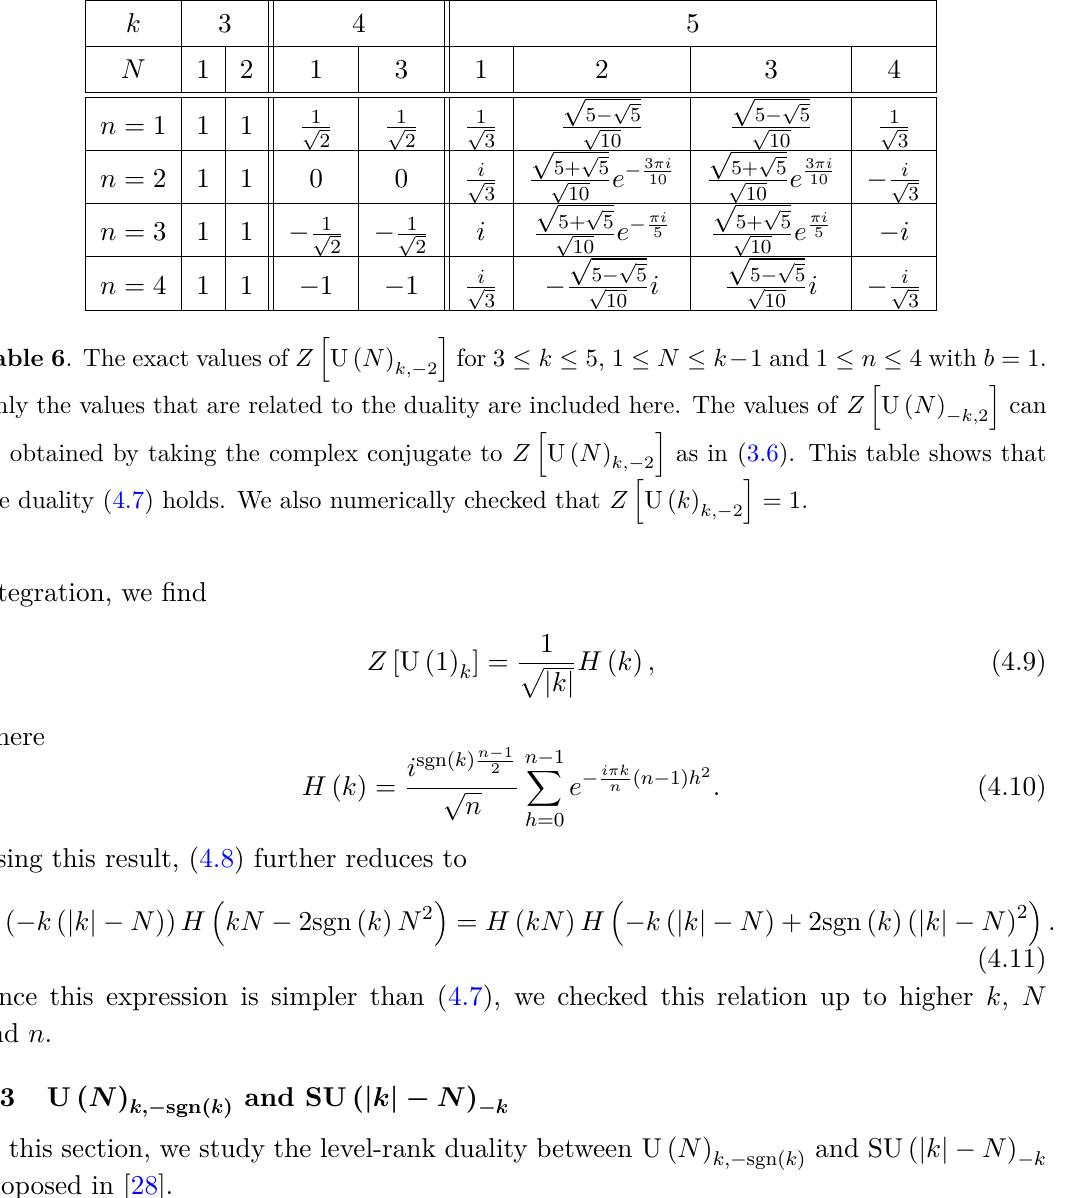
h i U ( N ) can − k, 2